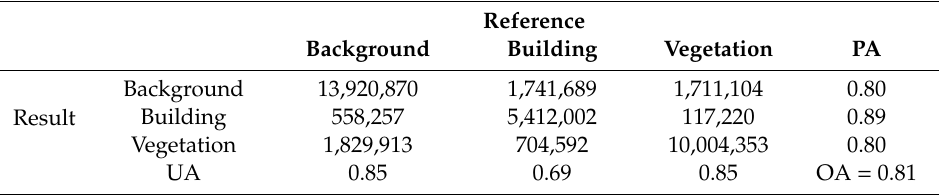
Figure 4. Results of Potsdam dataset. ( a ) Coarse image; ( b ) SASPM result; ( c ) VBSPM result; ( d ) SRM CNN result; and ( e ) reference. The second and third row were zoom-in areas from the first row. Table 7. Confusion matrix of SASPM result for Potsdam dataset.